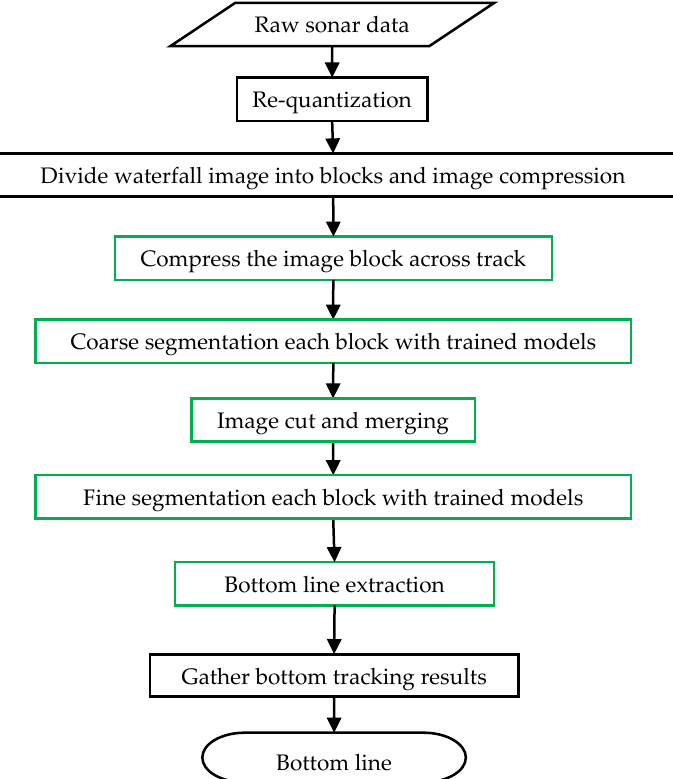
Bottom line Figure 9. Flowchart of the bottom tracking method based on semantic segmentation. Figure 9. Flowchart of the bottom tracking method based on semantic